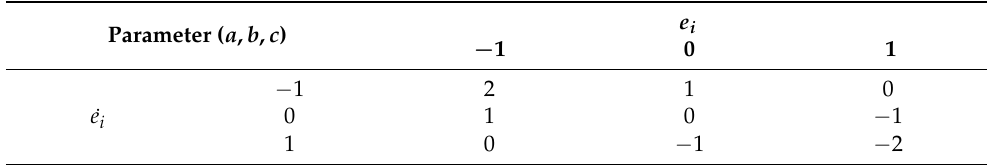
Table 1. The inference fuzzy system for learning a , b , and c